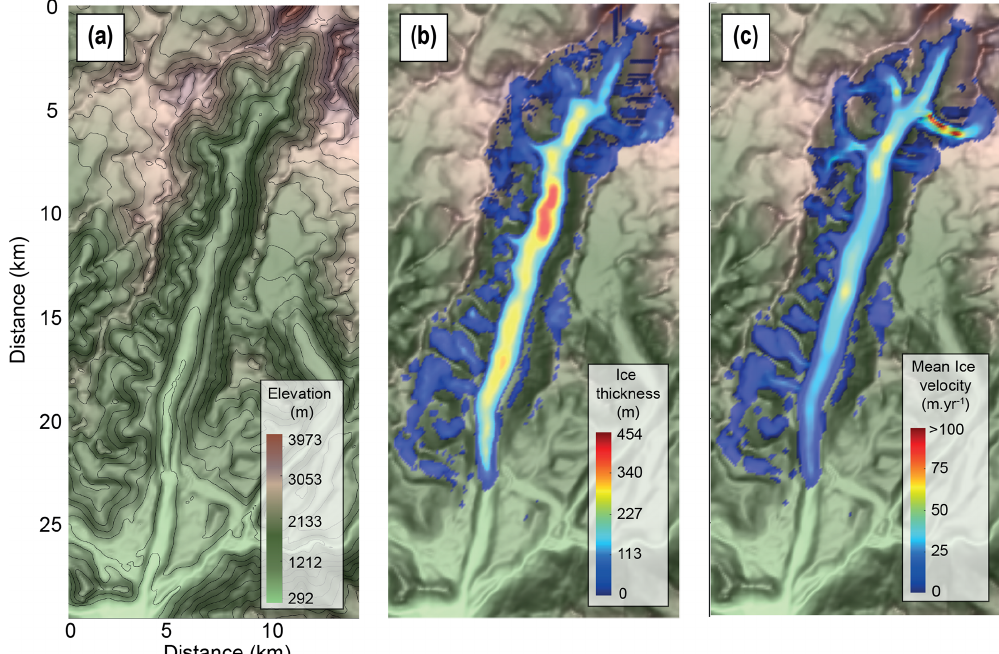
Figure 3. Characteristics of the Tiedemann Glacier model. (a) The underlying topography, (b) ice thickness, and (c) mean ice velocity. The mean ice thickness has been calibrated with the ITMIX experiments (see Fig.